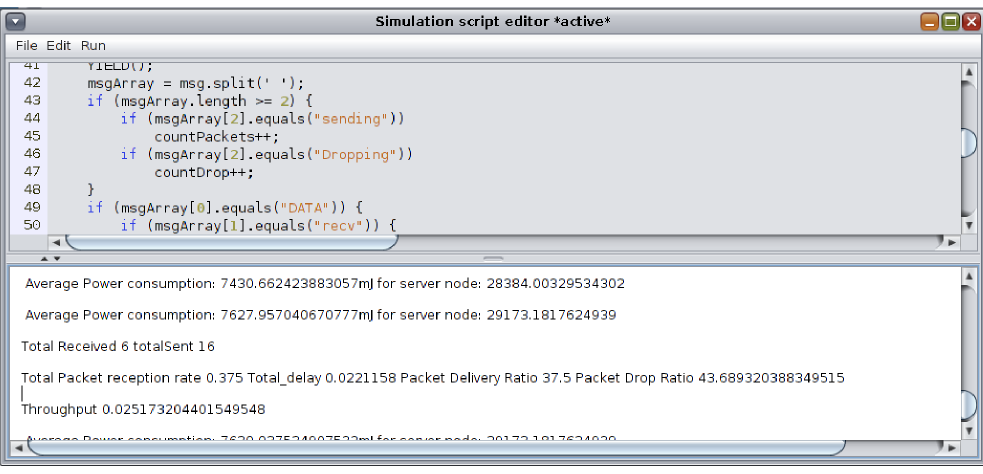
Figure 15. Cooja simulation script